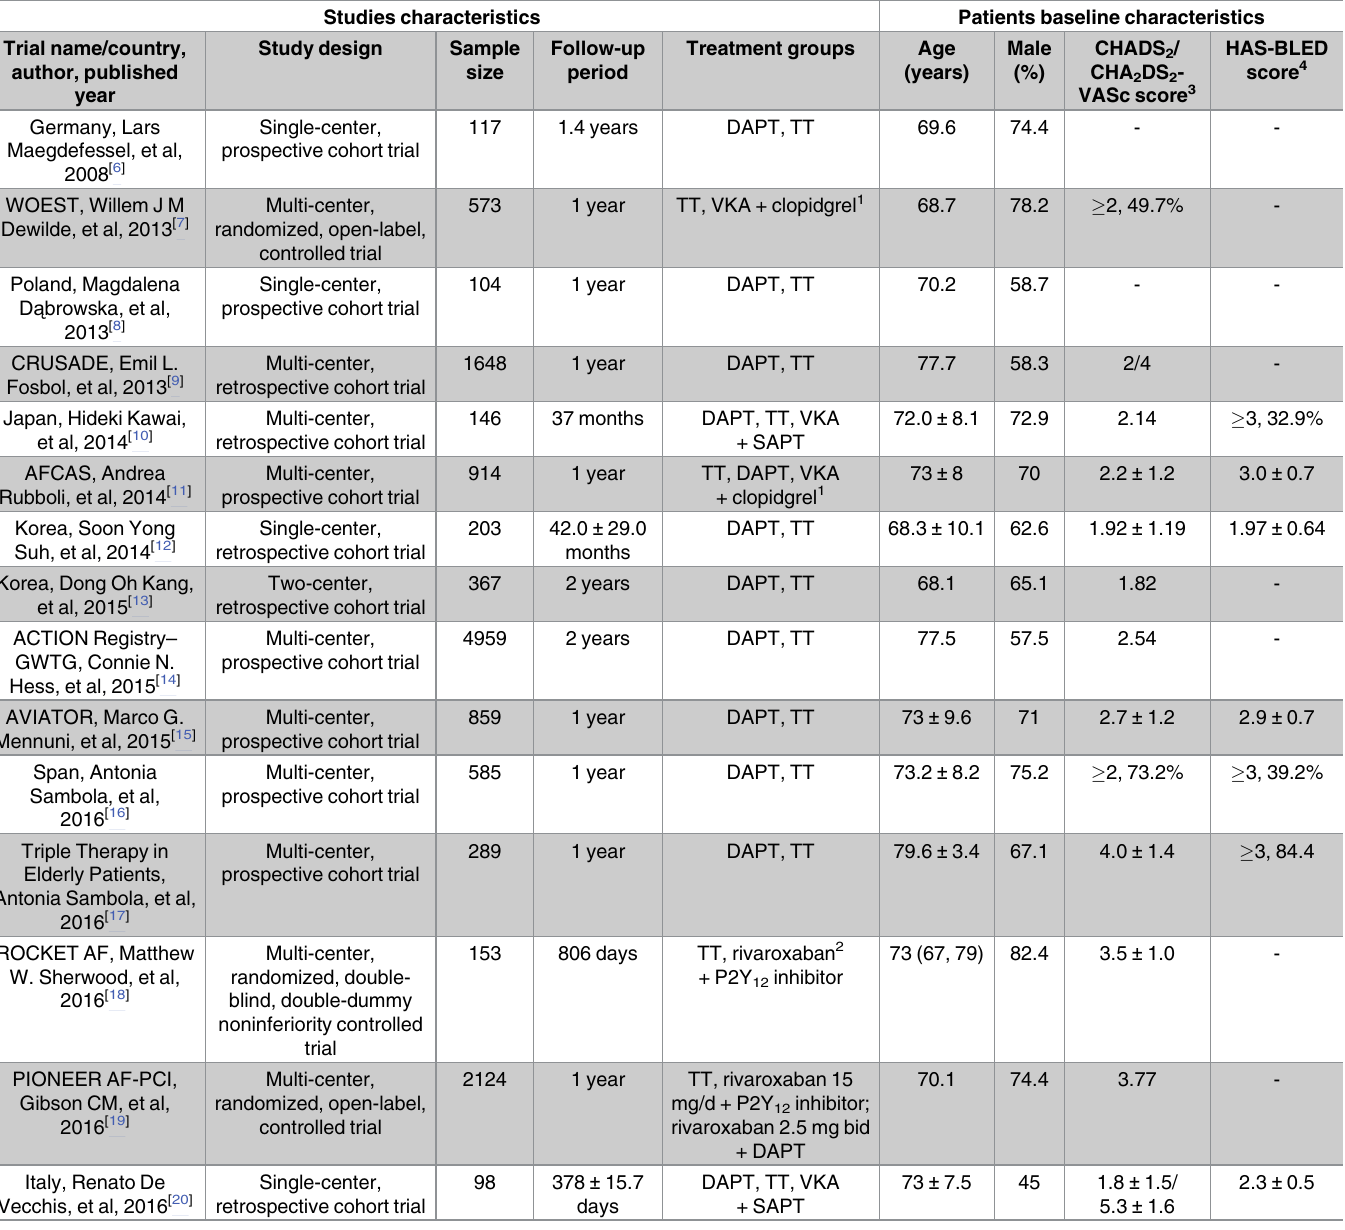
Table 1. Main characteristics of studies and patients included in the network